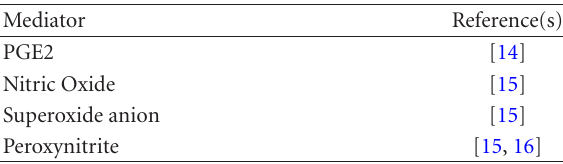
Table 2. Carrageenan-evoked proinflammatory